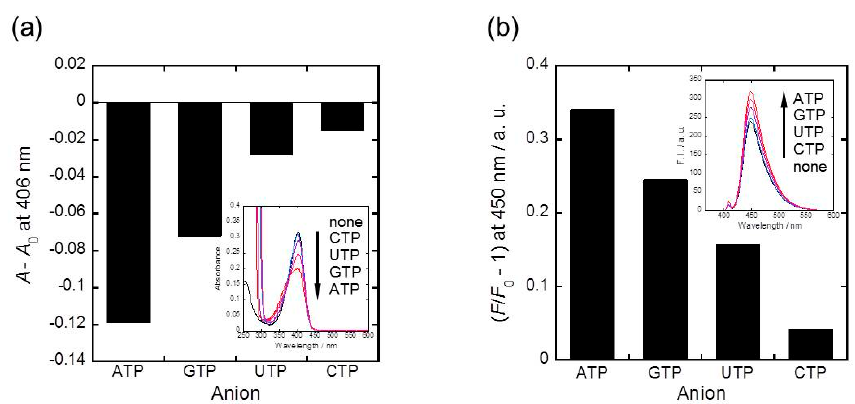
Figure 5. ( a ) UV-Vis and ( b ) Fluorescence responses of Cu·1 β in the presence of nucleoside triphosphates in water, pH 6.4 adjusted by PIPES/NaOH buffer, at 25 °C ( λ ex = 408 nm). [ 1 β ] = 0.010 mM, [Cu(NO 3 ) 2 ] = 0.010 mM, [nucleoside triphosphate] = 1.0 mM.